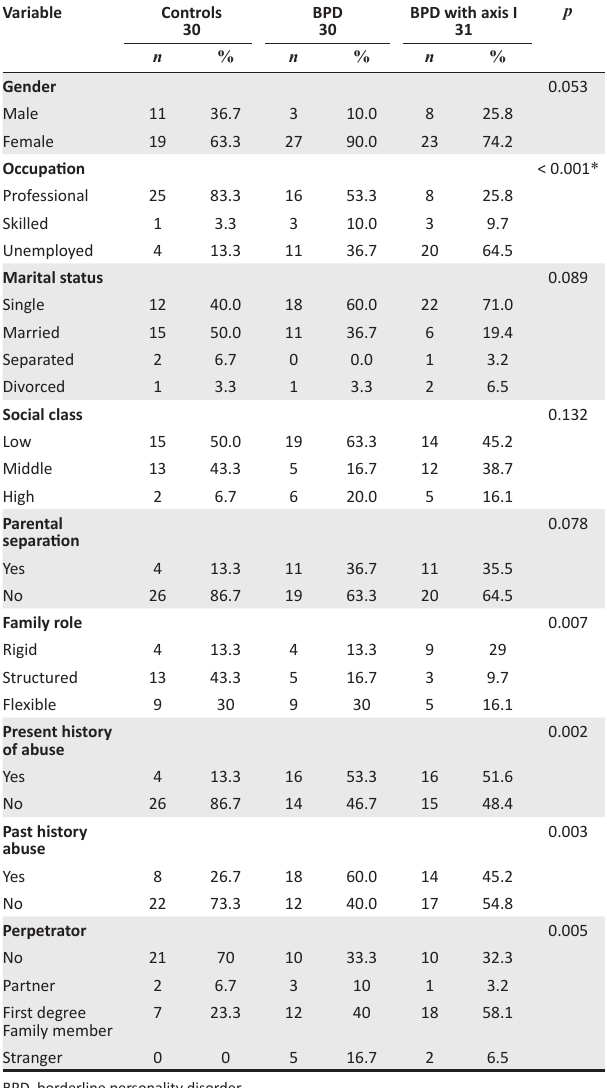
TABLE 1 : Socio-demographic and family